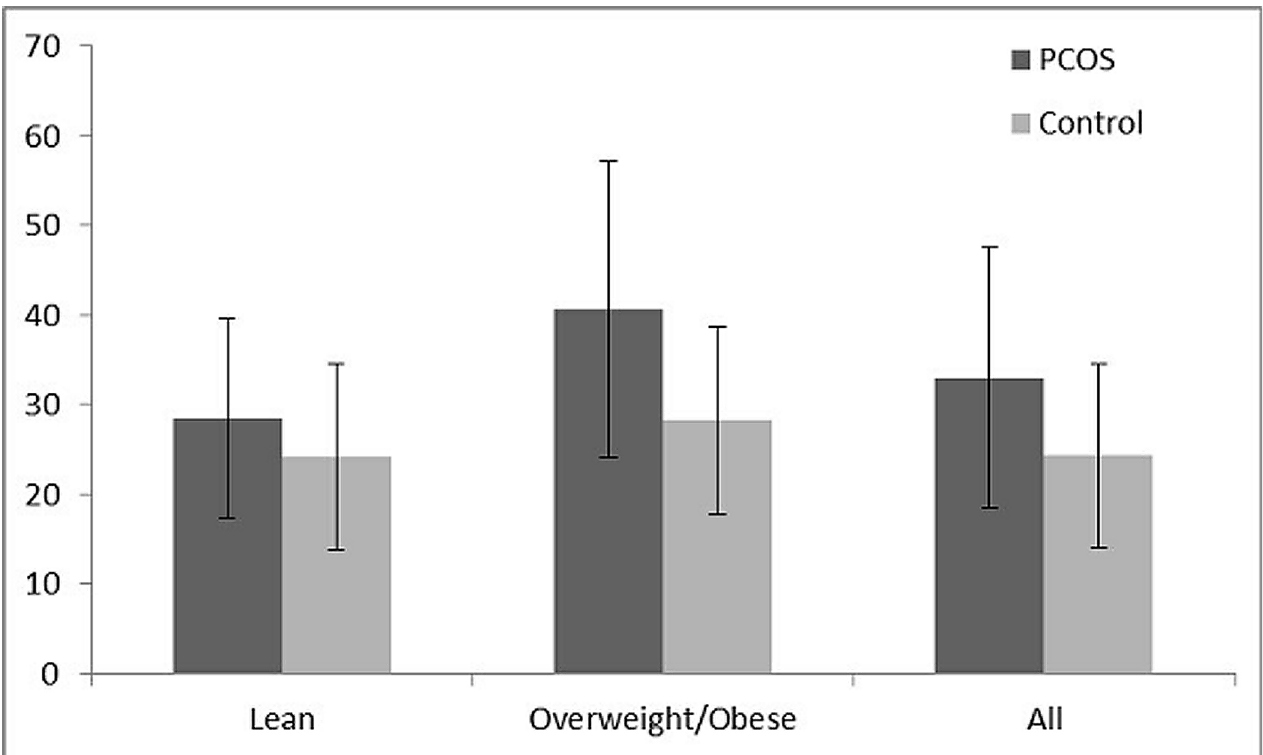
Fig 1. Serum LBP concentrations between PCOS and controls.